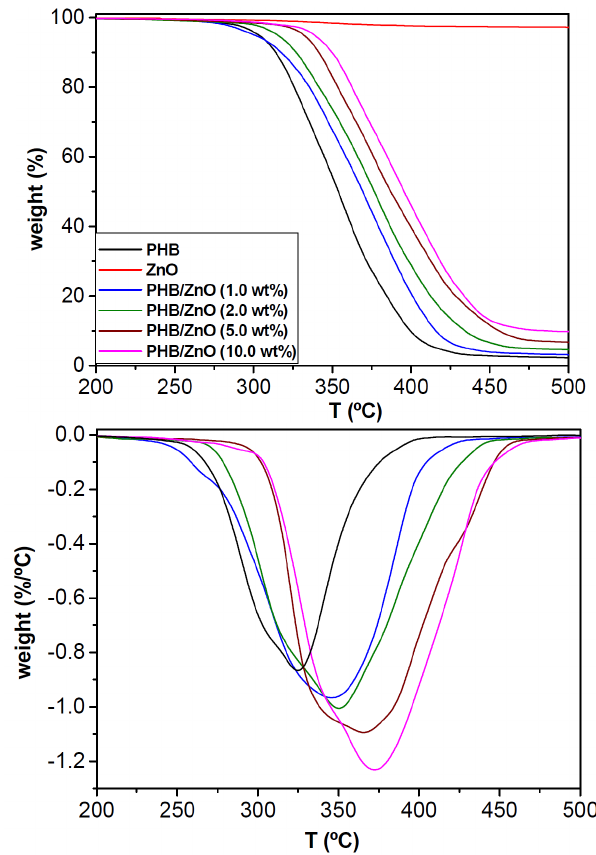
Figure 4. TGA ( top ) and DTG ( bottom ) curves for neat PHB, ZnO and the nanocomposites with different nanoparticle loadings.